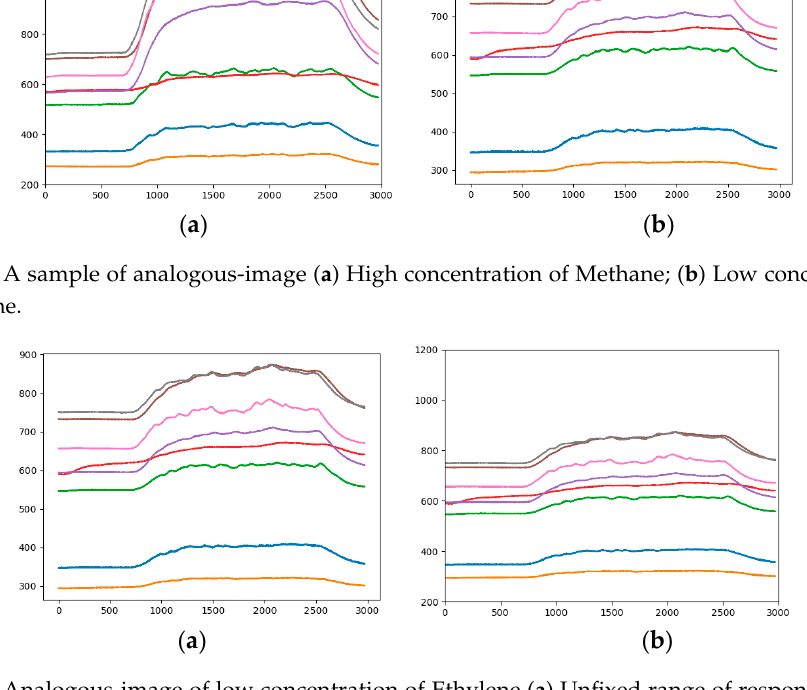
Figure 4. Analogous-image of low concentration of Ethylene ( a ) Unfixed range of response values; ( b ) Fixed range of response values.